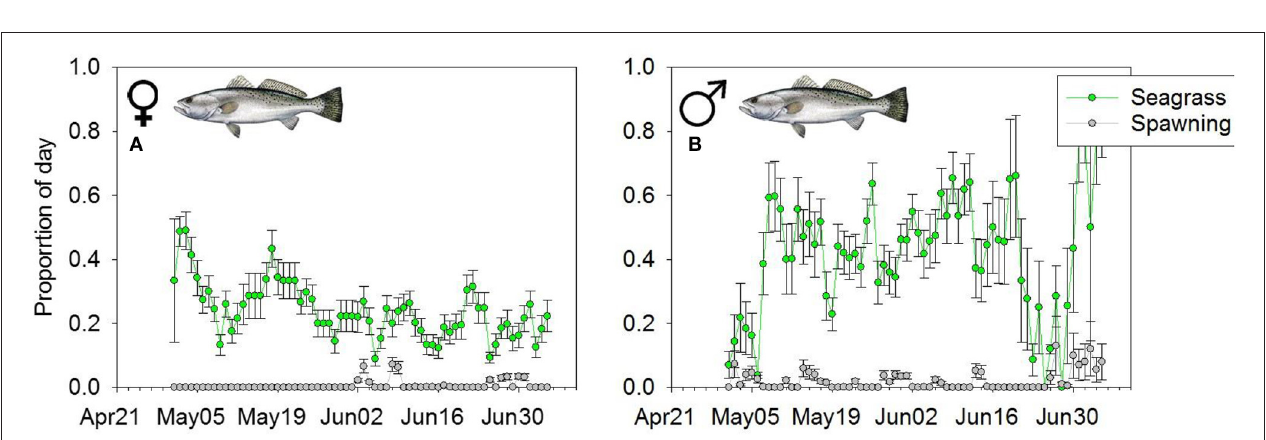
FIGURE 5 | Mean daily proportion use of (A) female and (B) male Seatrout of the spawning (gray line) or foraging (green line) habitat. Error bars represent (1 ±